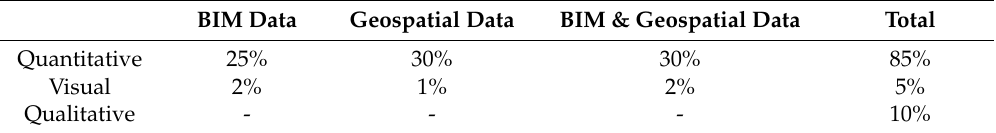
Table 1. Classification of the property criteria in the list of allowed values. The values correspond to the proportion of the total number of property criteria.